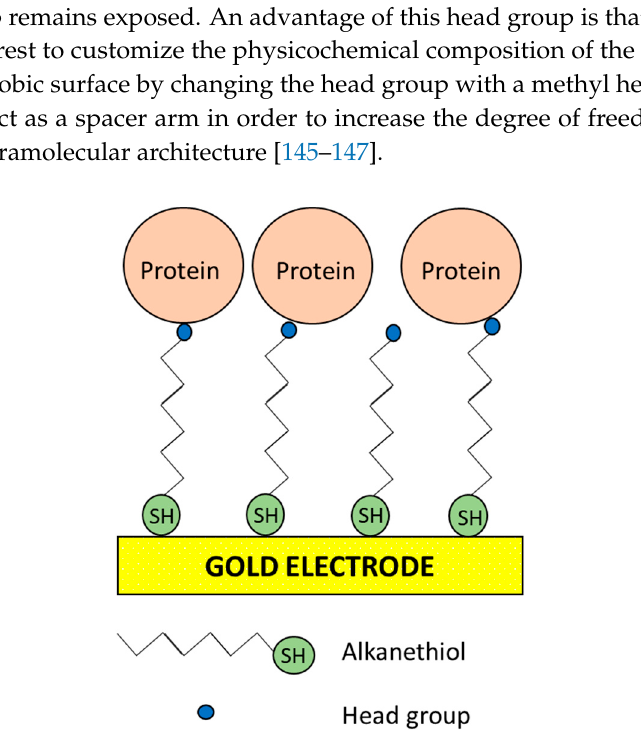
Figure 11. General scheme of the principal components of a SAM based on thiol groups. In the case of alkanethiol, the alkane aliphatic chain acts as a spacer arm in order to increase the degrees of freedom of the SAM and, in general, of the supramolecular architecture. Thiol tends to form a metal-S bond with the electrode surface leaving the head group exposed [85,146].